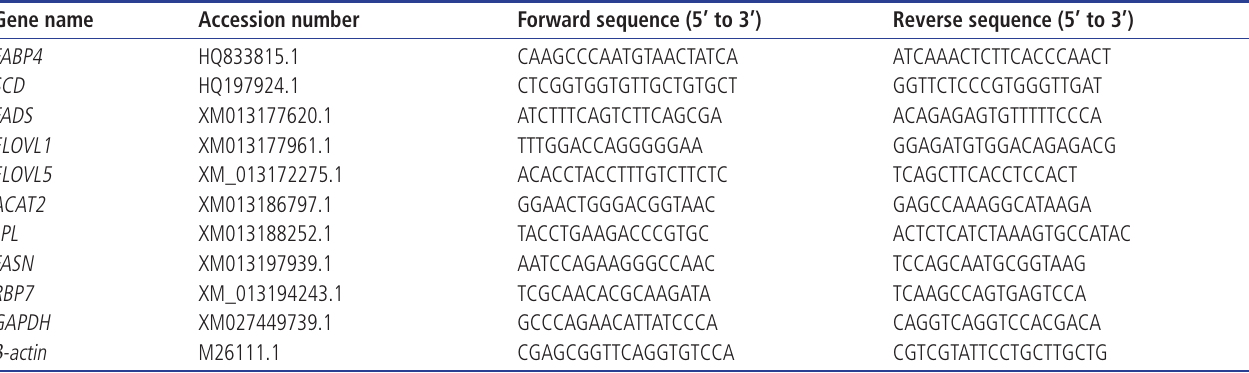
FABP4, adipocyte fatty acid binding protein; SCD, stearoyl-CoA desaturase; FADS, fatty acid dehydrogenase; ELOVL1, elongase of long-chain fatty acid 1; ELOVL5, elongase of long-chain fatty acid 5; ACAT2, cholesterol acyltransferase 2; LPL, lipoprotein lipase; FASN, fatty acid synthase; RBP7, retinol binding protein 7; GAPDH, glyceralde- hyde-3-phosphate dehydrogenase; β -actin, beta-actin.